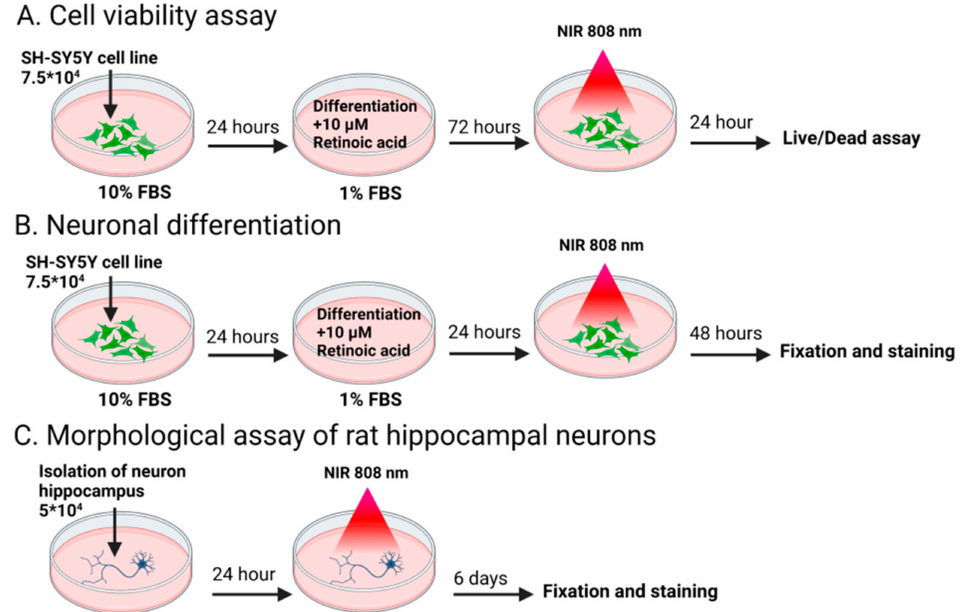
Figure 1. Experimental procedure for cell manipulation: scheme illustrates procedure viability assay ( A ), neuronal differentiation of human neuroblastoma SH-SY5Y cells ( B ), analysis of neurite elongation of rat hippocampal neuron ( C ) under NIR